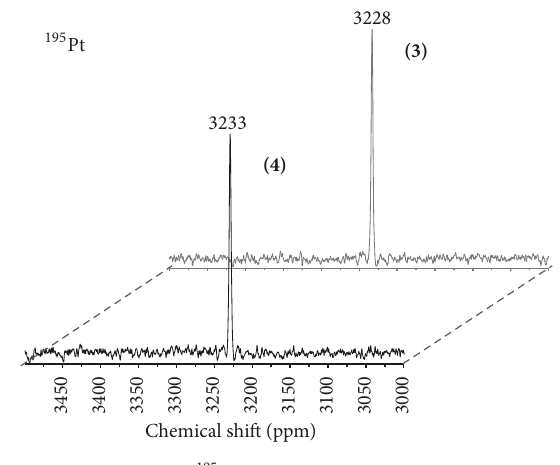
Figure 2: 195 Pt NMR complexes 3 and 4